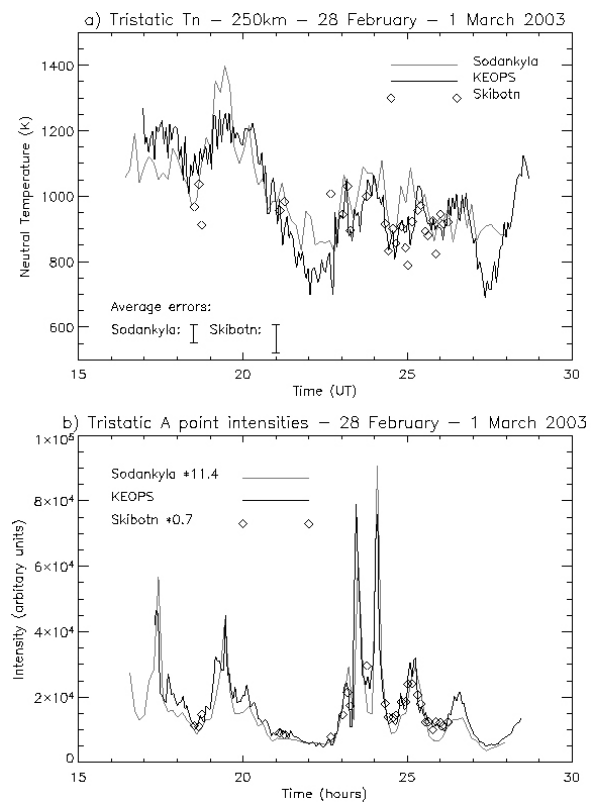
Fig. 8. (a) Comparison of thermospheric temperatures from inde- pendent measurements of a common volume by 3 FPIs on the night of 28 February–1 March 2003. (b) Comparison of the normalised intensities from the 3 FPIs for this night.